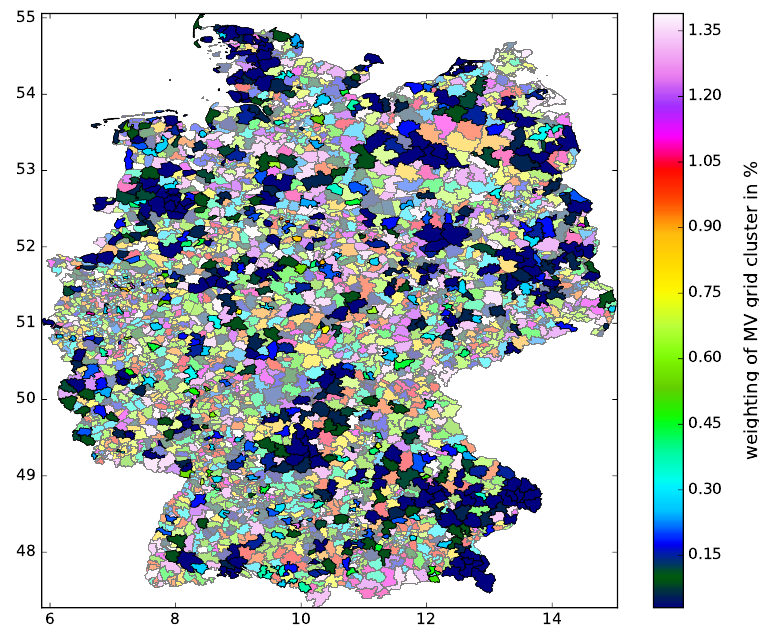
Figure 5. Relative deviation of grid expansion costs of different k cluster approximations compared to the calculation of all MV grids using the simple worst-case method.